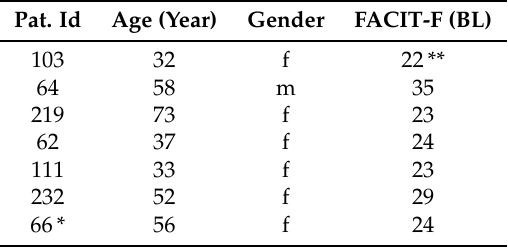
Table 4. Overview on the included study participants. BL: baseline (**: value after week 1); *: drop out. Pat. Id